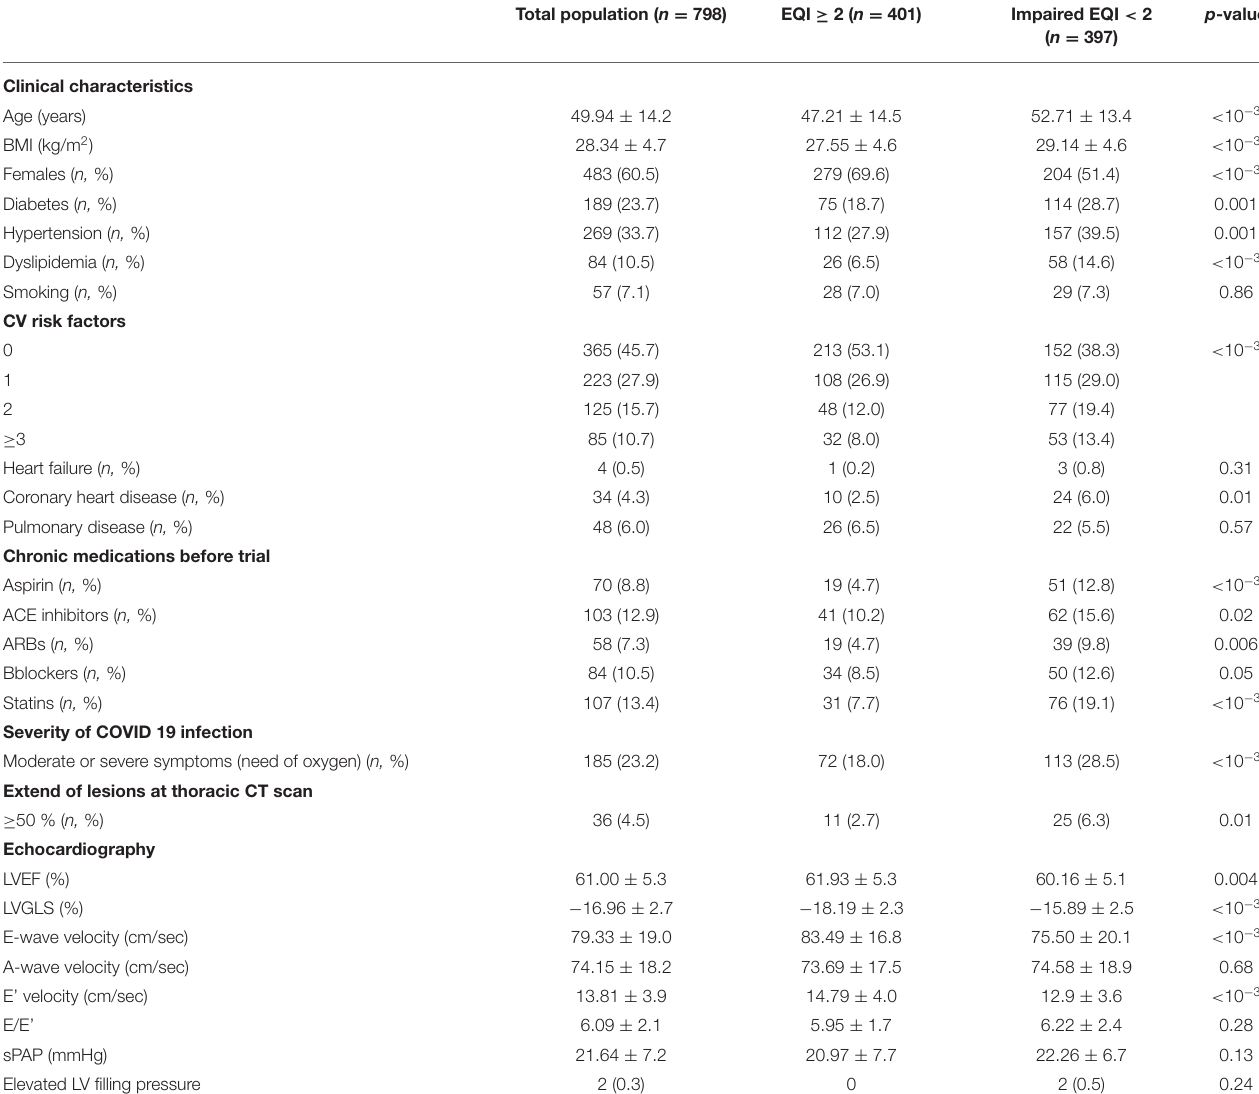
TABLE 4 | Baseline characteristics in the study population according to endothelium quality index.